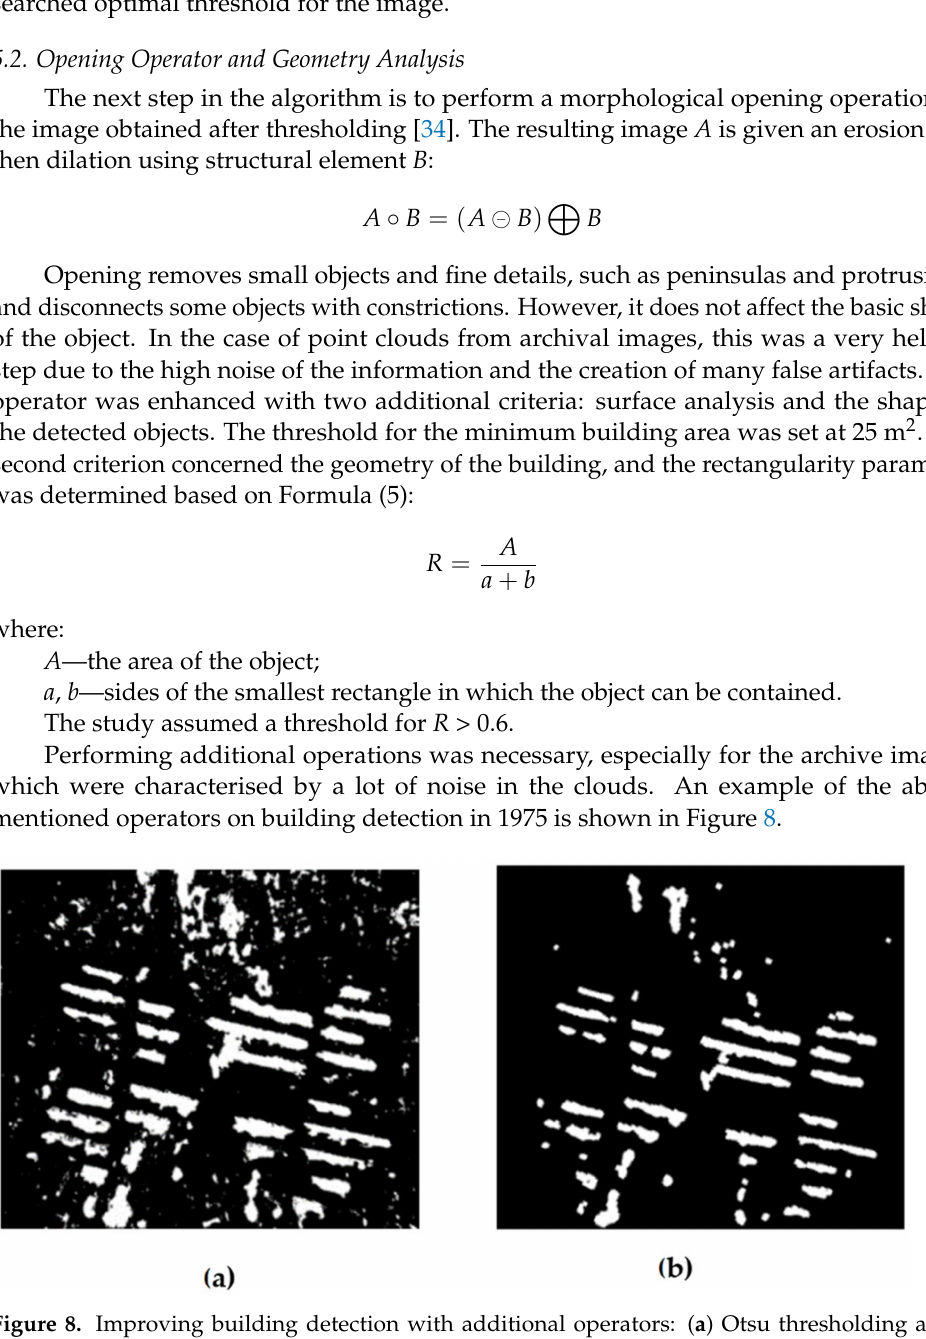
Figure 8. Improving building detection with additional operators: ( a ) Otsu thresholding alone, ( b ) additional